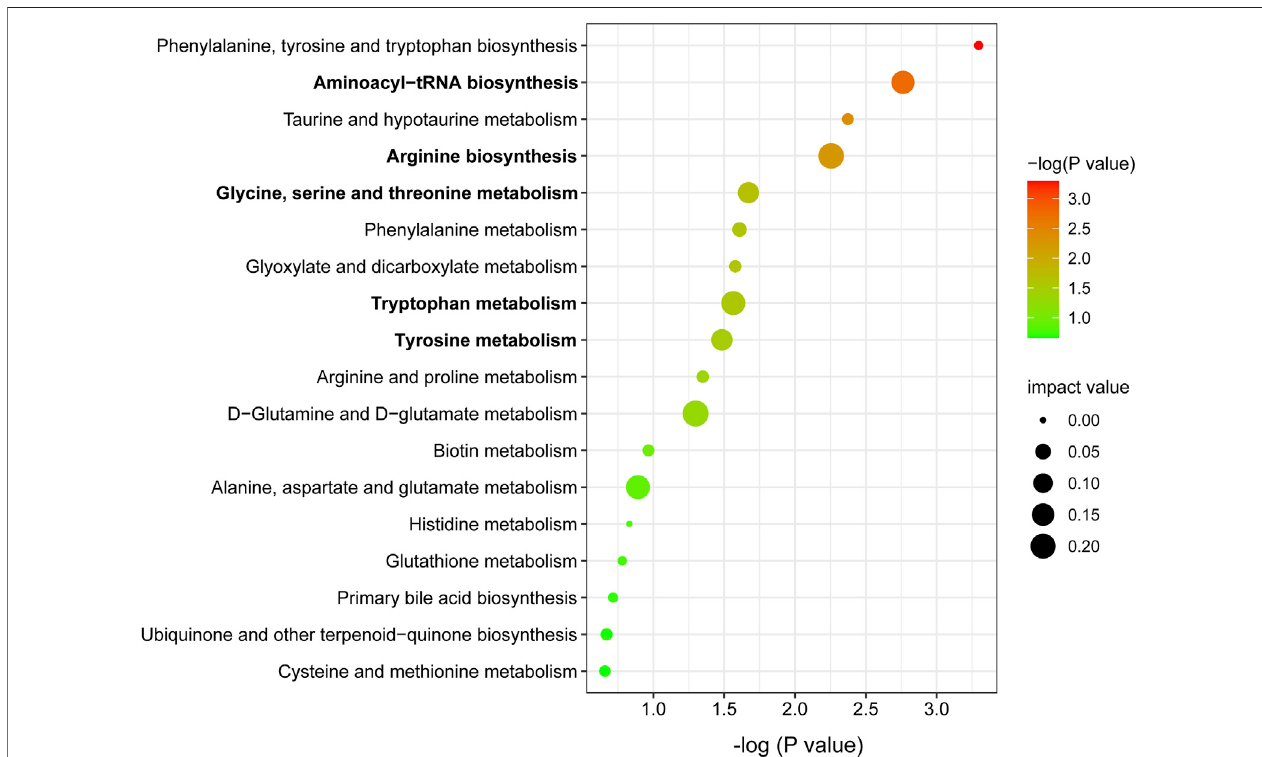
FIGURE 5 | Metabolic pathway enrichment analysis of differentially expressed metabolites. Node size is based on impact value, node color is based on − log (P) value. The pathways marked in bold are statistically different with impact value > 0.1 and p < 0.05.